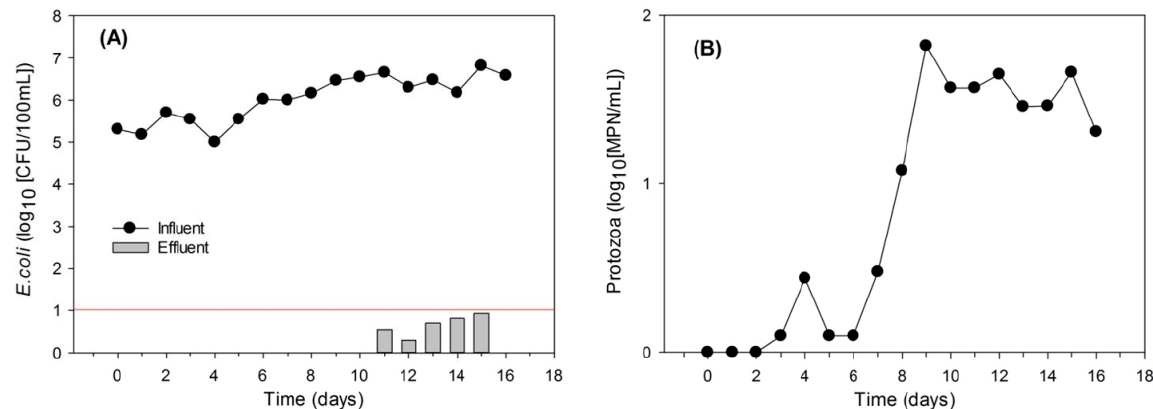
Figure 6. E. coli removal in two sequential columns ( A ). E. coli in influent and effluent, ( B ) Protozoa detection in treated wastewater.